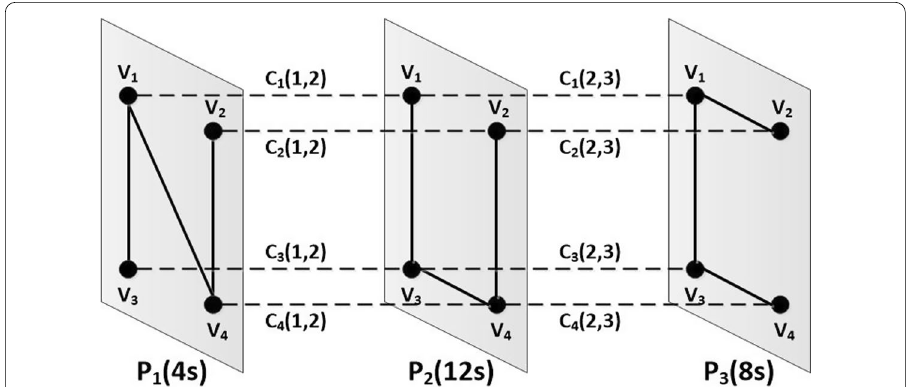
Fig. 4 Example of a temporal network based on the DSAM